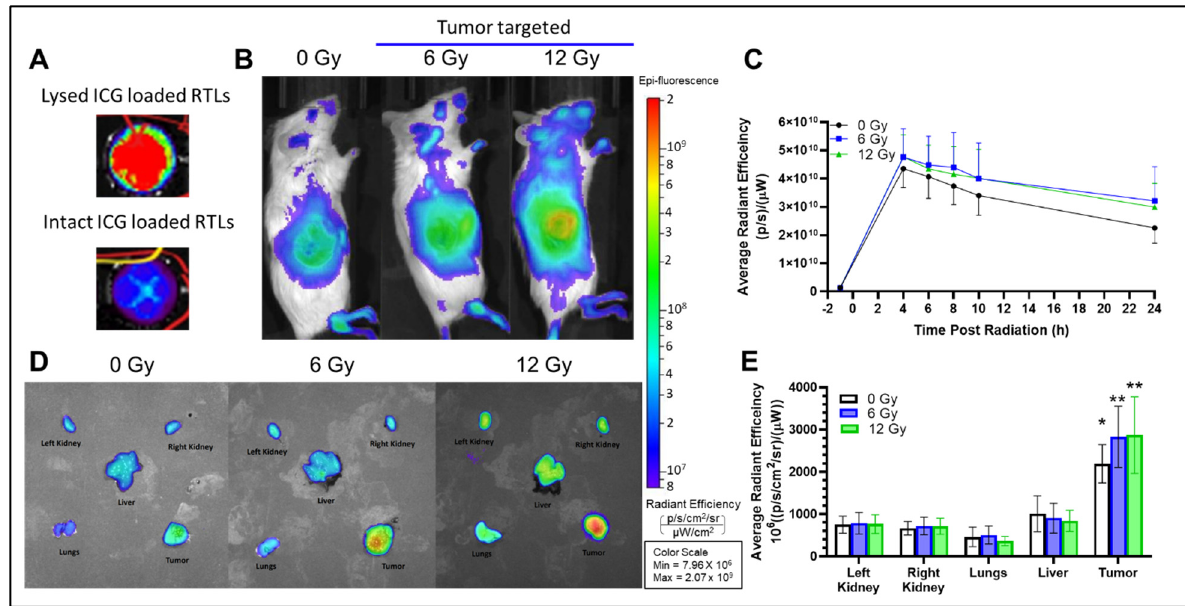
Figure 4. Radiation release of ICG-loaded RTLs. ( A ) Self-quenching ICG loaded liposomes. ( B ) Rep- resentative lateral IVIS images of ICG associated fluorescence 4 h post injection and immediately after radiation. ( C ) Average radiant efficiency in the tumor region over the course of 24 h post radiation. ( D ) Representative ex vivo IVIS imaging of ICG associated fluorescence in vital organs and tumor at 24 h post radiation. ( E ) Average radiant efficiency of vital organs and tumor. Data presented as mean ± SEM; n = 5–6. One-way ANOVA with Tukey post hoc for comparison of all tissues to tumor for each group (* p < 0.05, ** p <